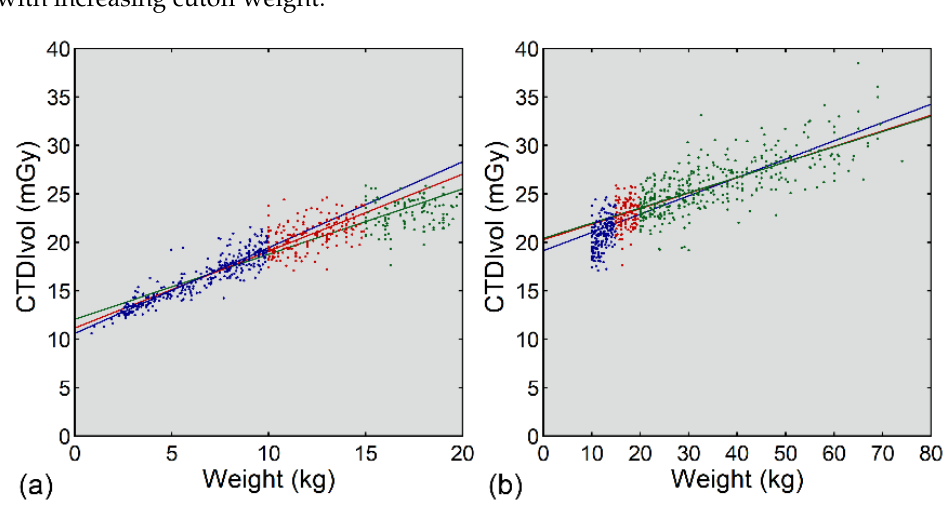
Table 1. Age range and results of linear regression between CTDIvol and age.